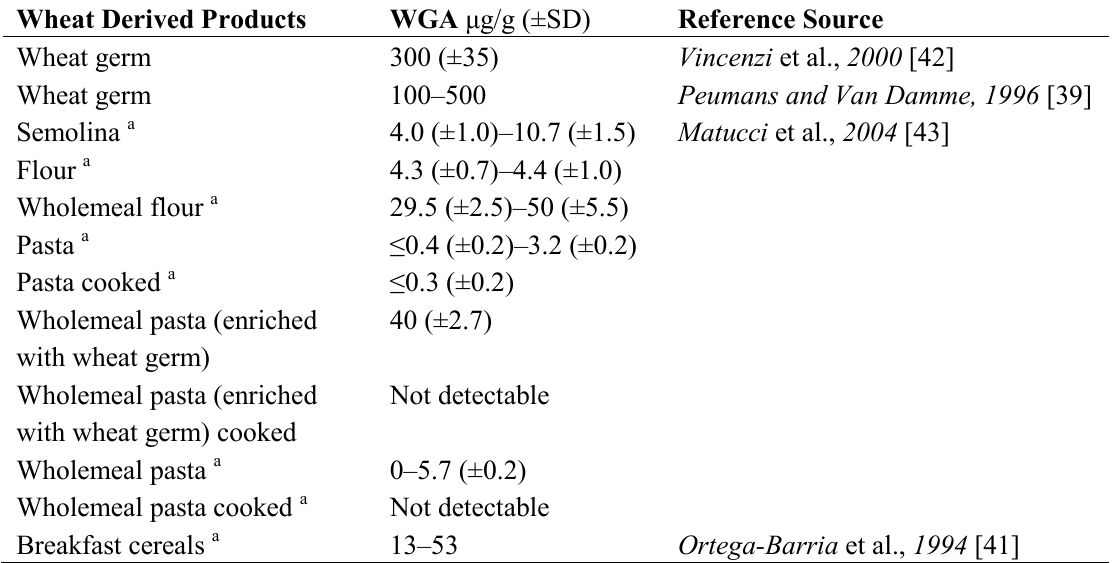
Table 1. Amount of active WGA in wheat-derived